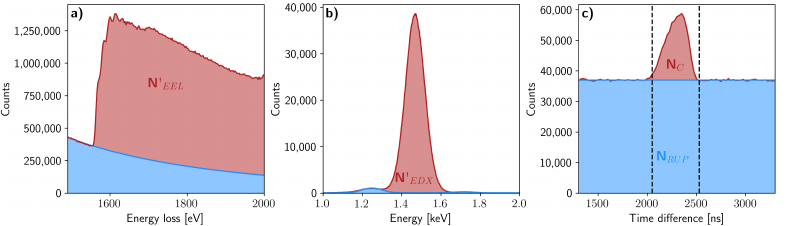
Figure 1. ( a ) Conventional electron energy loss (EEL) spectrum where the K-edge of aluminum is shown from an Al-Mg-Si-Cu alloy. The background is subtracted using power-law fit (blue area). The background is used to determine N (cid:48) . ( b ) The conventional energy dispersive X-ray (EDX) EEL spectrum where the main peak is a characteristic peak of aluminum. The background value is determined by fitting the spectrum to the sum of three Gaussian’s and a linear slope from which one Gaussian peak is the peak of interest. ( c ) Histogram of the number of correlated events as a function of time difference between the X-rays and electrons. The number of identified coincidence events N C is indicated on the